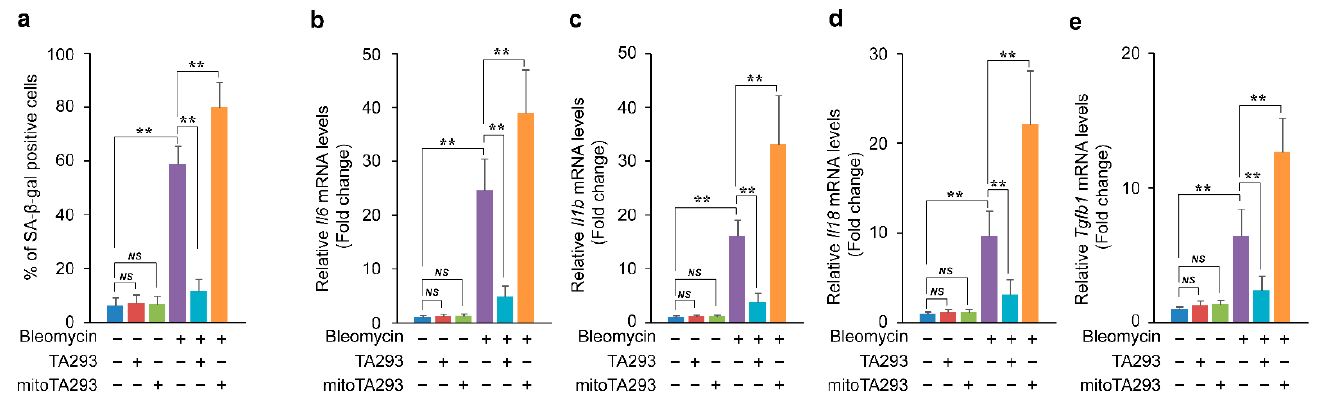
Figure 3. Effects of TA293 and mitoTA293 on oxidative stress and cellular senescence in BLM-induced primary pulmonary alveolar epithelial cells (PAECs) in vitro . ( a ) Quantification of cellular senescence in vitro . Expression of SASP factor mRNA: ( b ) Il6 , ( c ) Il1b , ( d ) Il18 , and ( e ) Tgfb1 . PAECs were treated with saline or BLM and with vehicle, TA293, or mitoTA293 for 72 h. The data are presented as the mean ± SEM ( n = 5 per group); ** p < 0.01; NS , not significant.